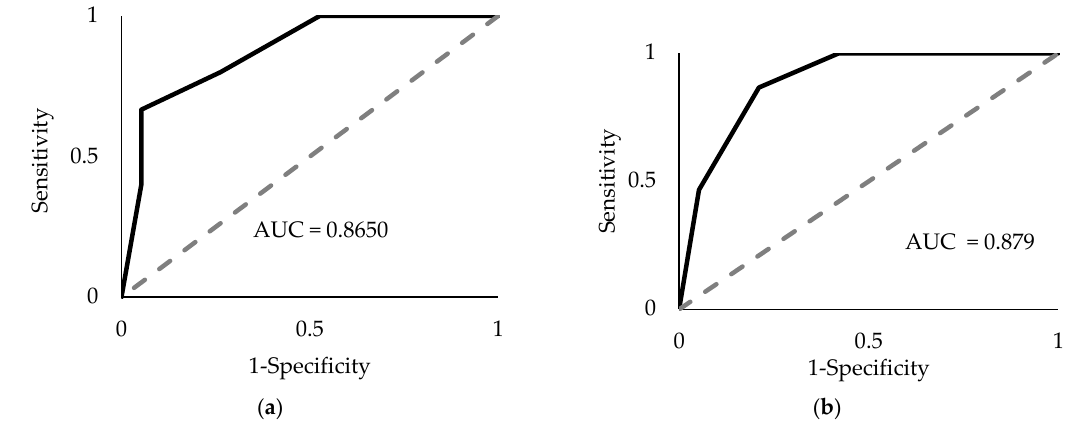
Figure 3. Receiver operator characteristic (ROC) area under the curve (AUC) analyses. The four- miRNA panel (miR-93-5p, miR-339-3p, miR-425-5p, and miR-425-3p) underwent ROC analysis using the upper limits of the average control ΔCq thresholds ( a ) and using the lower limit of the average PDAC ΔC q thresholds ( b ). The values are based off the average ΔCqs for each miRNA in either control or PDAC plasma samples with 99% CI for all such values.